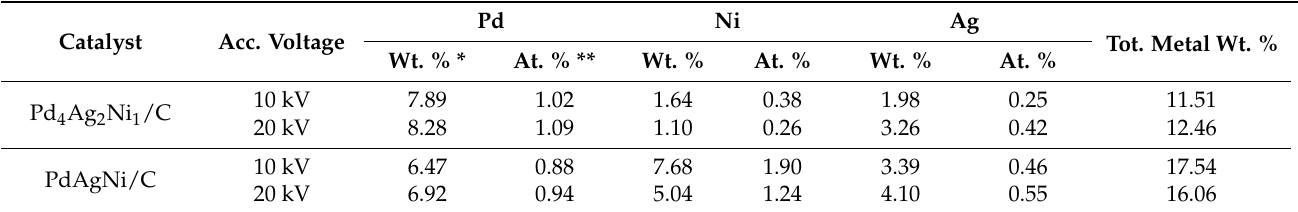
Table 2. EDX elemental metal composition of PdAgNi/C and Pd 4 Ag 2 Ni 1 /C detected at 20 kV and 10 kV voltages. Pd Ni Ag Catalyst Acc. Voltage At. % ** Wt. % At. % Wt. % At. %